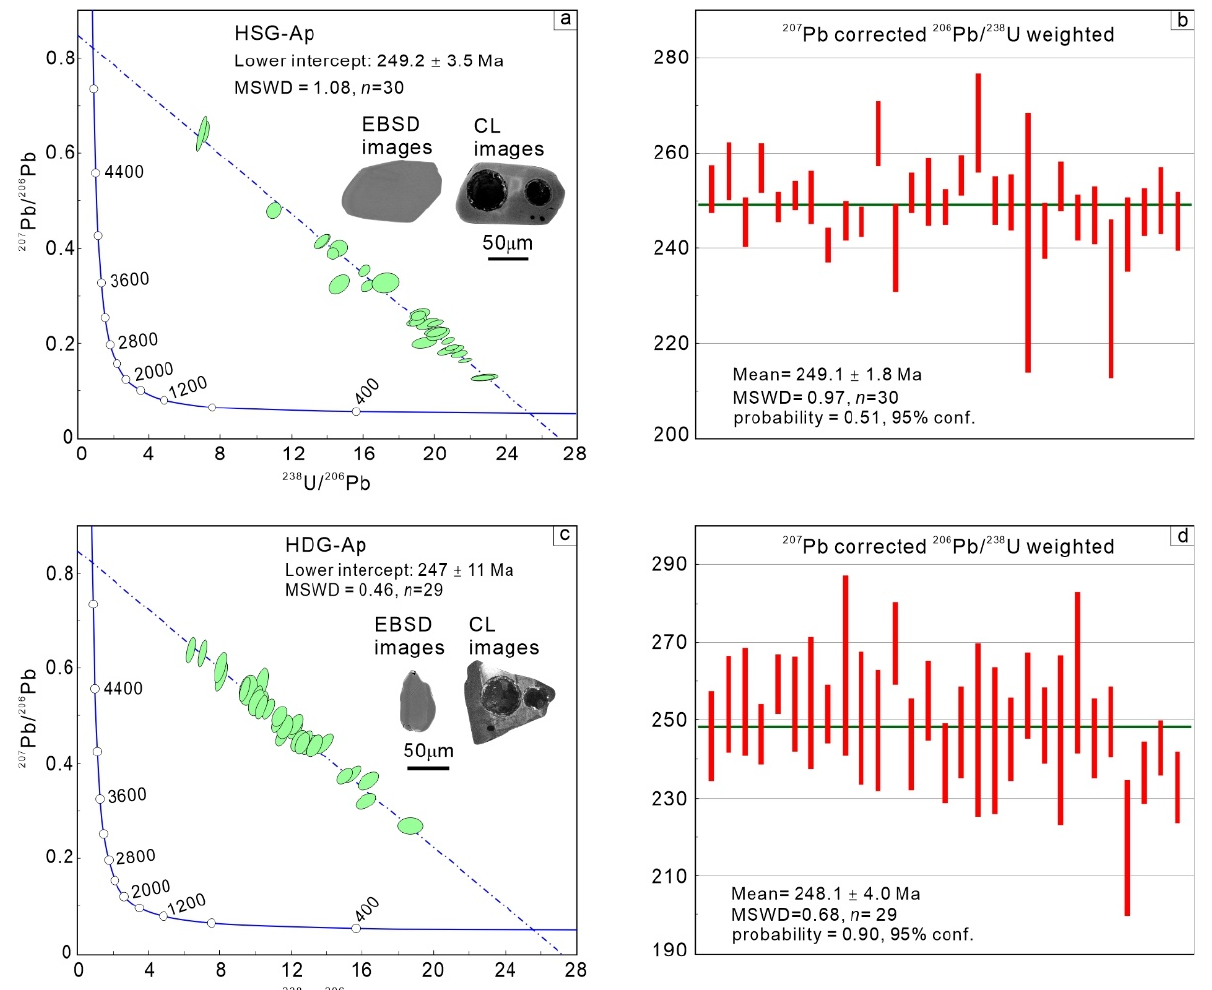
Figure 5. ( a ) U ‐ Pb concordia diagram of the apatite from the HSG. ( b ) Weighted mean 206 Pb/ 238 U age of the apatite from the HSG. ( c ) U ‐ Pb concordia diagram of the apatite from the HDG. ( d ) Weighted mean 206 Pb/ 238 U age of the apatite from the HDG. In situ zircon Hf isotopic analyses of HSG and HDG samples are presented in Table 6 and plotted in Figure 6. The initial 176 Hf/ 177 Hf ratios of HSG ranged from 0.282972 to 0.2830656 (mean = 0.283016, n = 25), with calculated ε Hf (t) values ranging from 12.2 to 15.2. The two-stage Hf model ages ( T DM2 ) range from 279.0 to 479.4 Ma, with an average of 381 Ma. The 176 Hf/ 177 Hf ratios of HDG samples range from 0.282875 to 0.282920 (mean = 0.282903, n = 10), with calculated ε Hf (t) values ranging from 10.5 to 12.2 (mean = 11.6, n =10). The two-stage Hf model ages ( T DM2 ) range from 552 to 655 Ma, with an average of 589.9